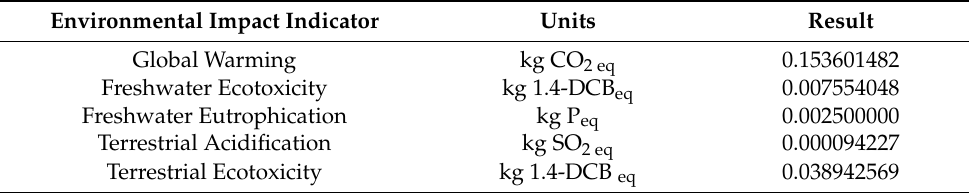
Table 4. The results of the different environmental impact indicators of Fund ã o’s cherry for the FU of 1 kg of produced